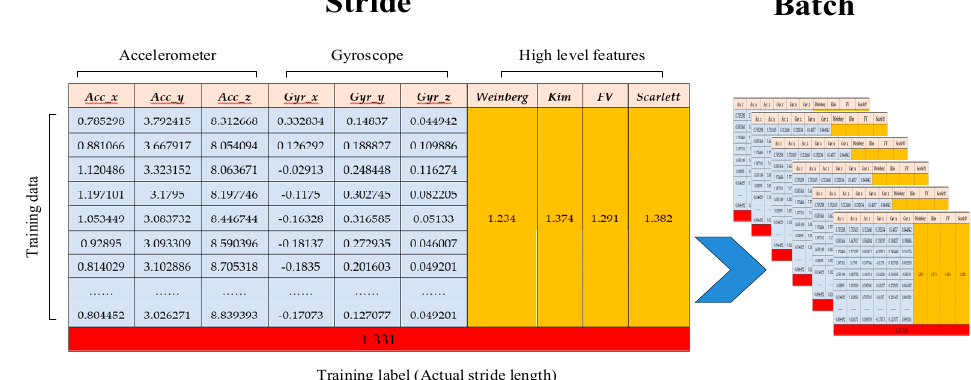
Figure 5. Input example for a stride-length estimation network.